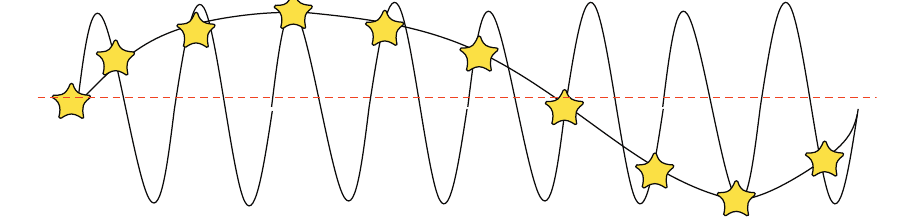
Figure 10: Frequency aliasing phenomenon.